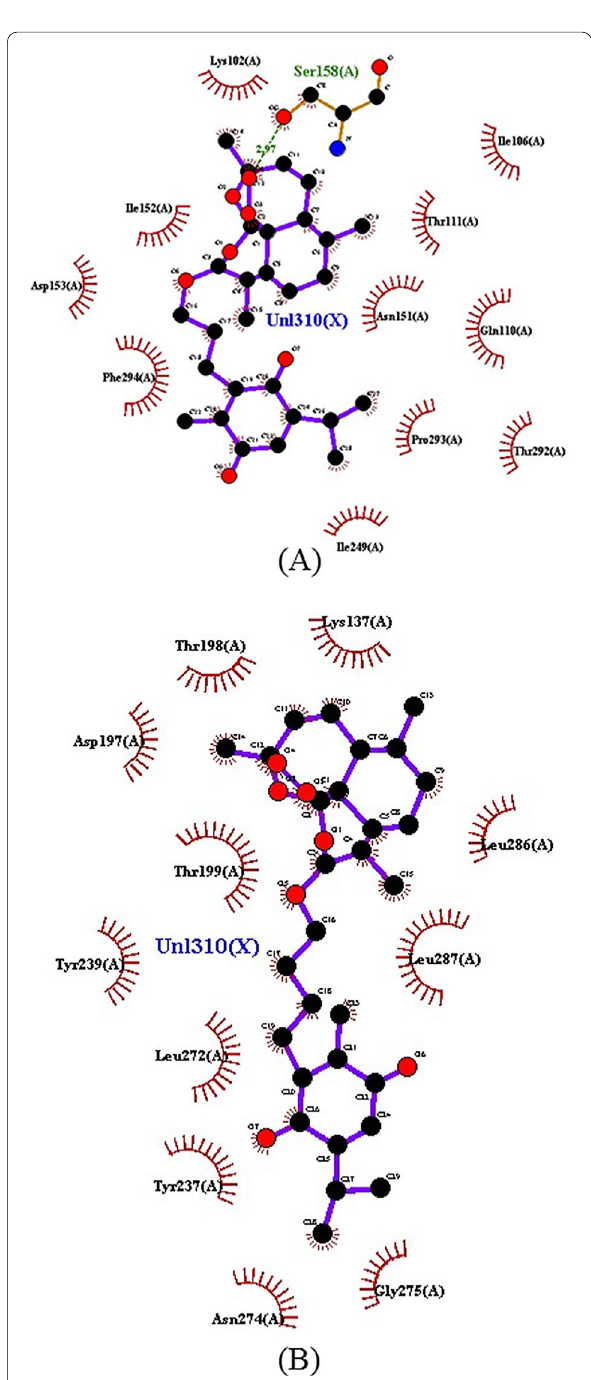
Fig. 8 2D map representative of H-bonds between ART-THY hybrids. A T6 e B